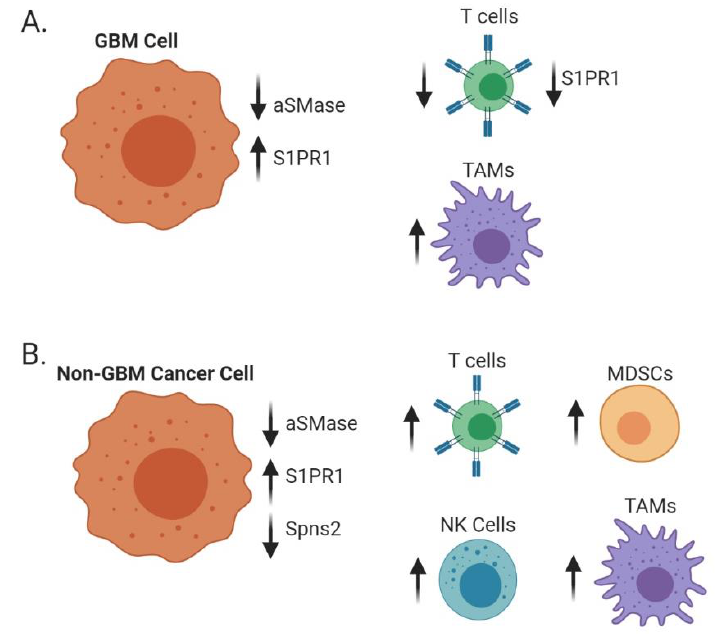
Figure 4. Alterations of sphingolipid metabolism affect surrounding immune populations. In GBM cells ( A ), low acid SMase and high S1PR1 on GBM cells but low S1PR1 on T cells decrease T cell recruitment while increasing macrophage recruitment and polarization towards an immunosuppressive (M2) phenotype. In metastatic brain cancers ( B ), such as melanoma, breast, and lung, decreases in acid SMase and Spns2 with increases in S1PR1 can increase recruitment and activation of both adaptive and innate immune cells.